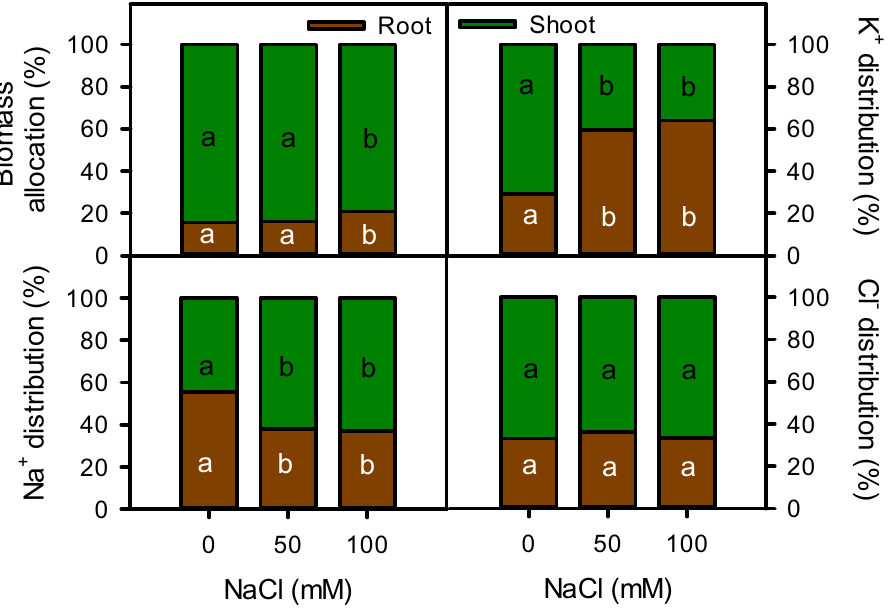
Figure 3. Biomass allocation and Na + and Cl − distribution in root and shoot of Moringa oleifera under different salinity treatments. Different letters indicate significant differences at P <